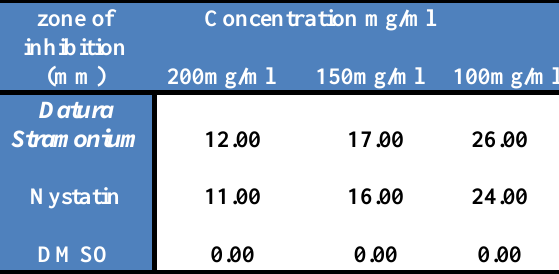
Table, 3: Sensitivity test of different concentration from leaves extract of Datura stramonium.